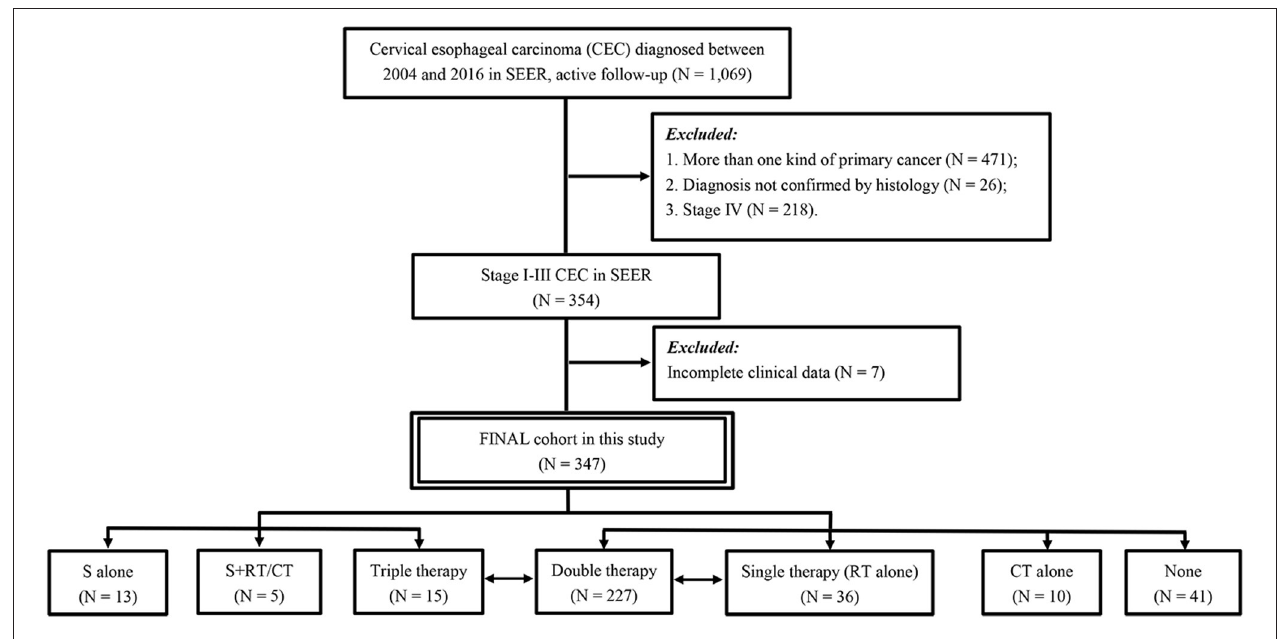
FIGURE 1 | Patient selection